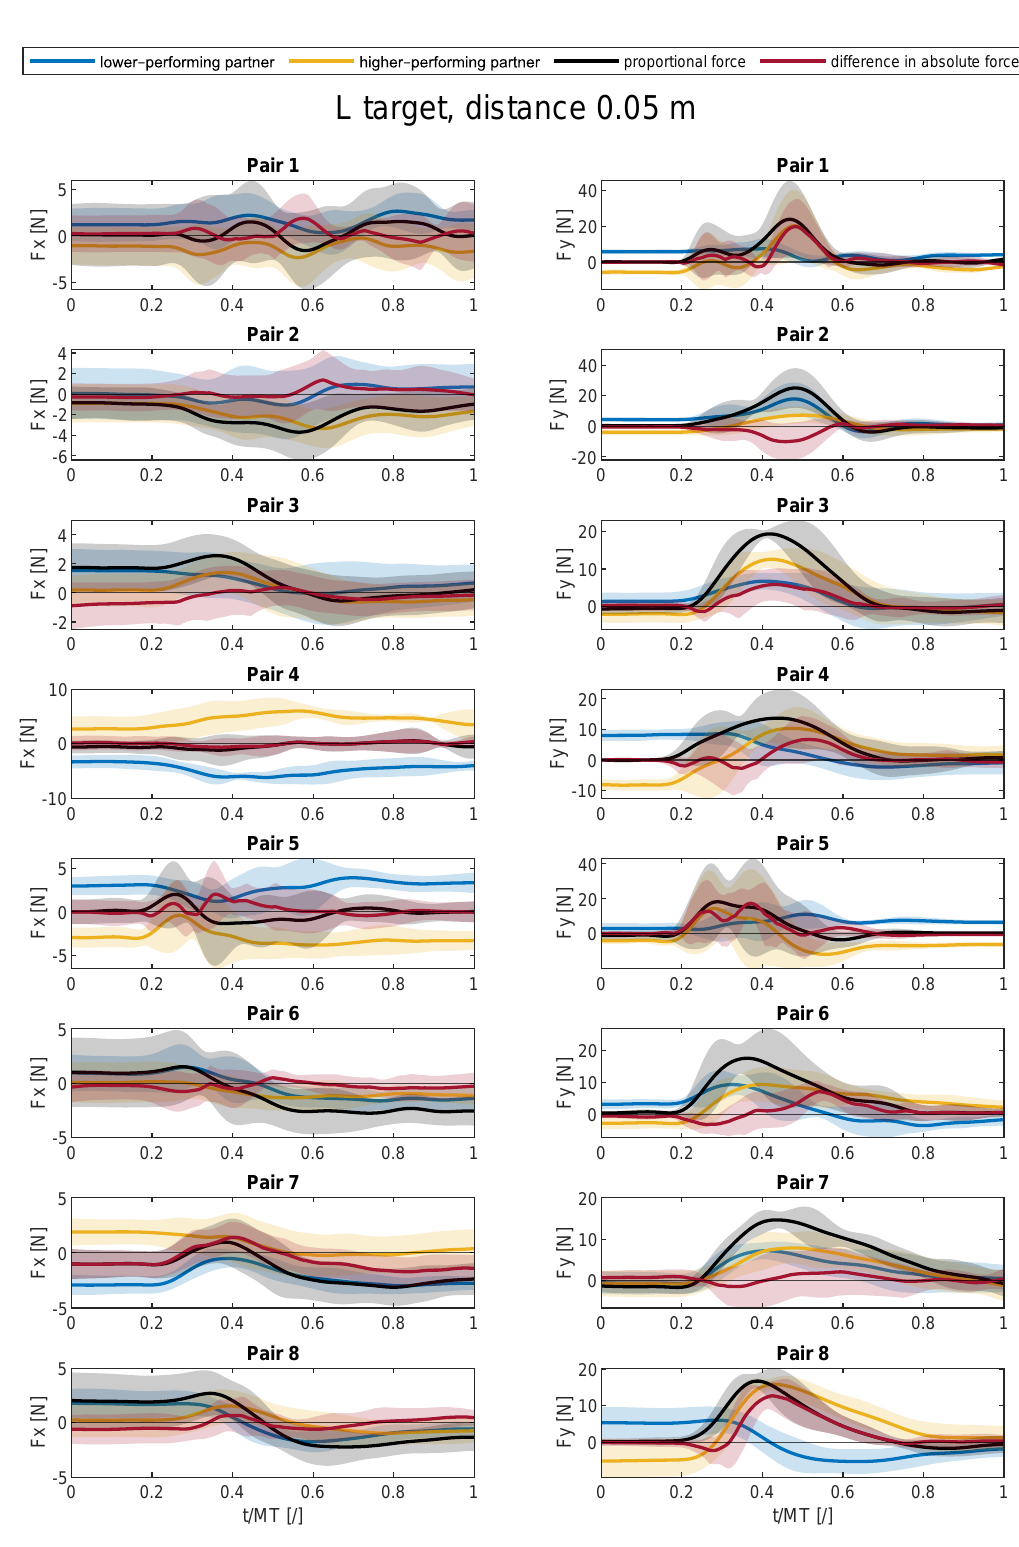
Figure A7. Average force trajectories with standard deviation (shaded area) in x- and y-direction in collaborative task for the large target at the distance of 0.05